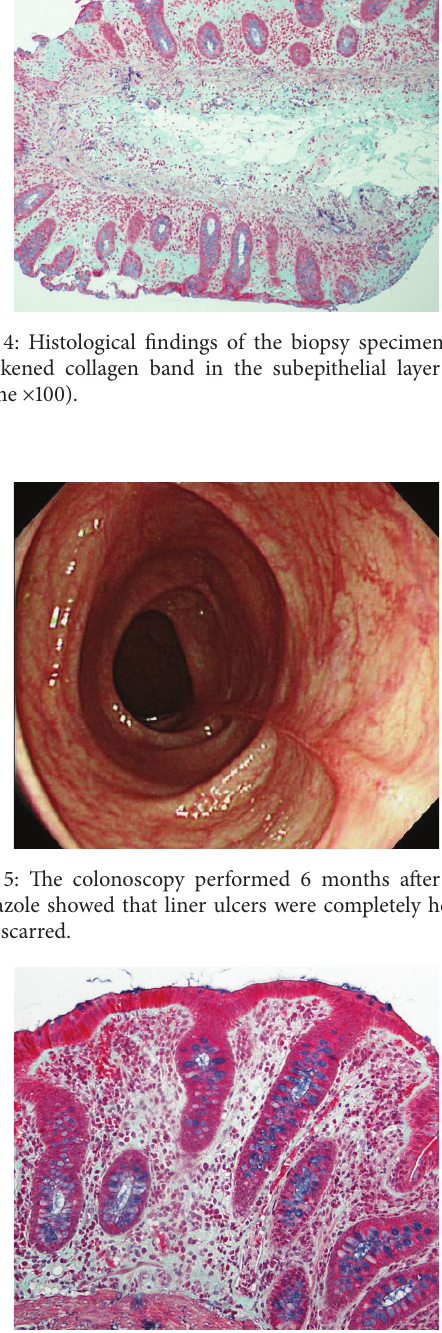
Figure 6: Disappearance of collagen band was confirmed from the histological findings of the ascending colon biopsy specimen (Masson trichrome ×